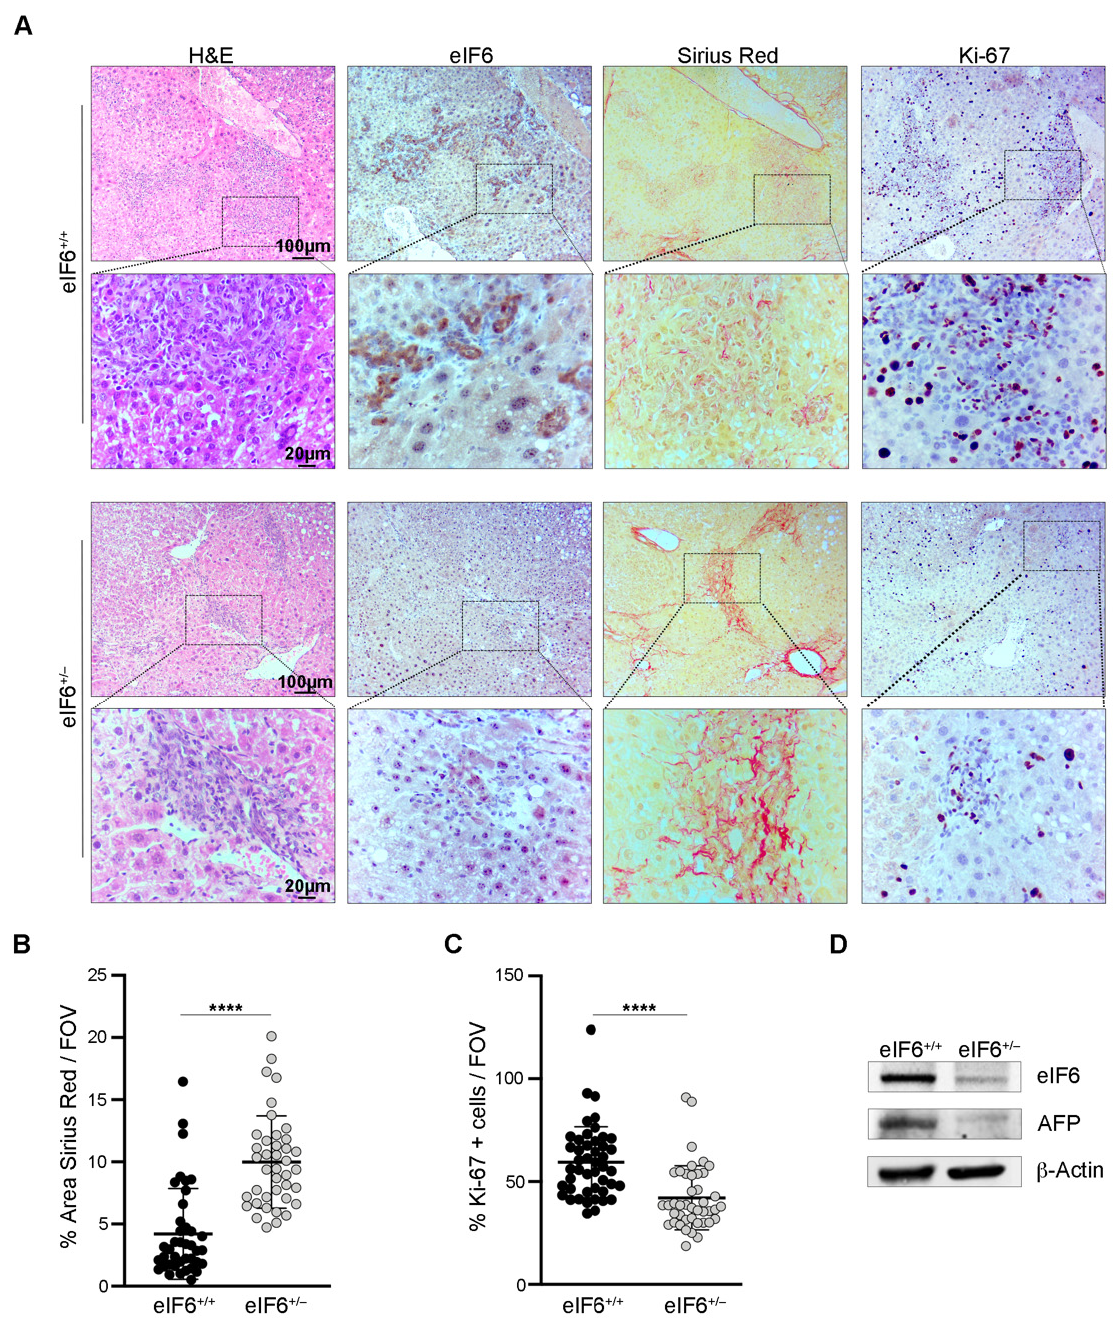
Figure 3. HCC tumor growth is reduced in eIF6 +/ − livers. ( A ) Representative images of liver sections for the indicated stains and immunohistochemistry derived from mice sacrificed at the late time point (18 weeks). Scale bars are indicated. ( B ) Quantification of the Sirius Red positive areas. Hepatic fibrosis is increased in eIF6 +/ − livers. n = 10 fields of view (FVO)/mouse. Data are represented as percentages and the bold black lines indicate the mean ± SD. Results of a two-tailed t test are shown. **** p value ≤ 0.0001. ( C ) Quantification of Ki-67 positive cells. Proliferation rate is decreased in eIF6 +/ − livers. n = 10 fields of view (FVO)/mouse. Data are represented as percentages and the bold black lines indicate the mean ± SD. Results of a two-tailed t test are shown. **** p value ≤ 0.0001. ( D ) Representative Western blotting of eIF6 +/+ and eIF6 +/ − liver protein extracts. AFP protein levels are higher in eIF6 +/+ livers. β -Actin was used as a loading